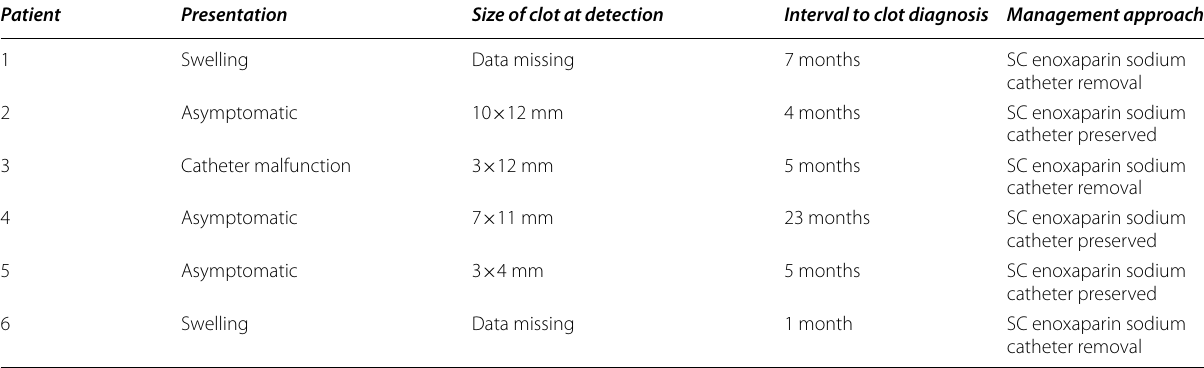
Abbreviations: SC subcutaneous